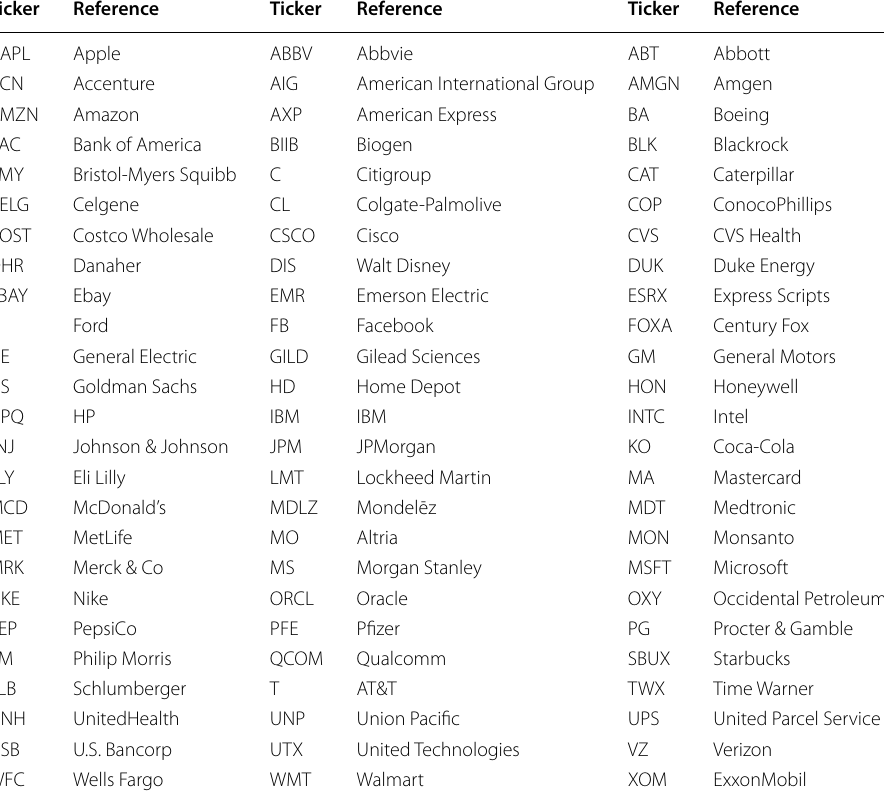
Table 2 Ticker symbols and EventRegistry concepts for news retrieval